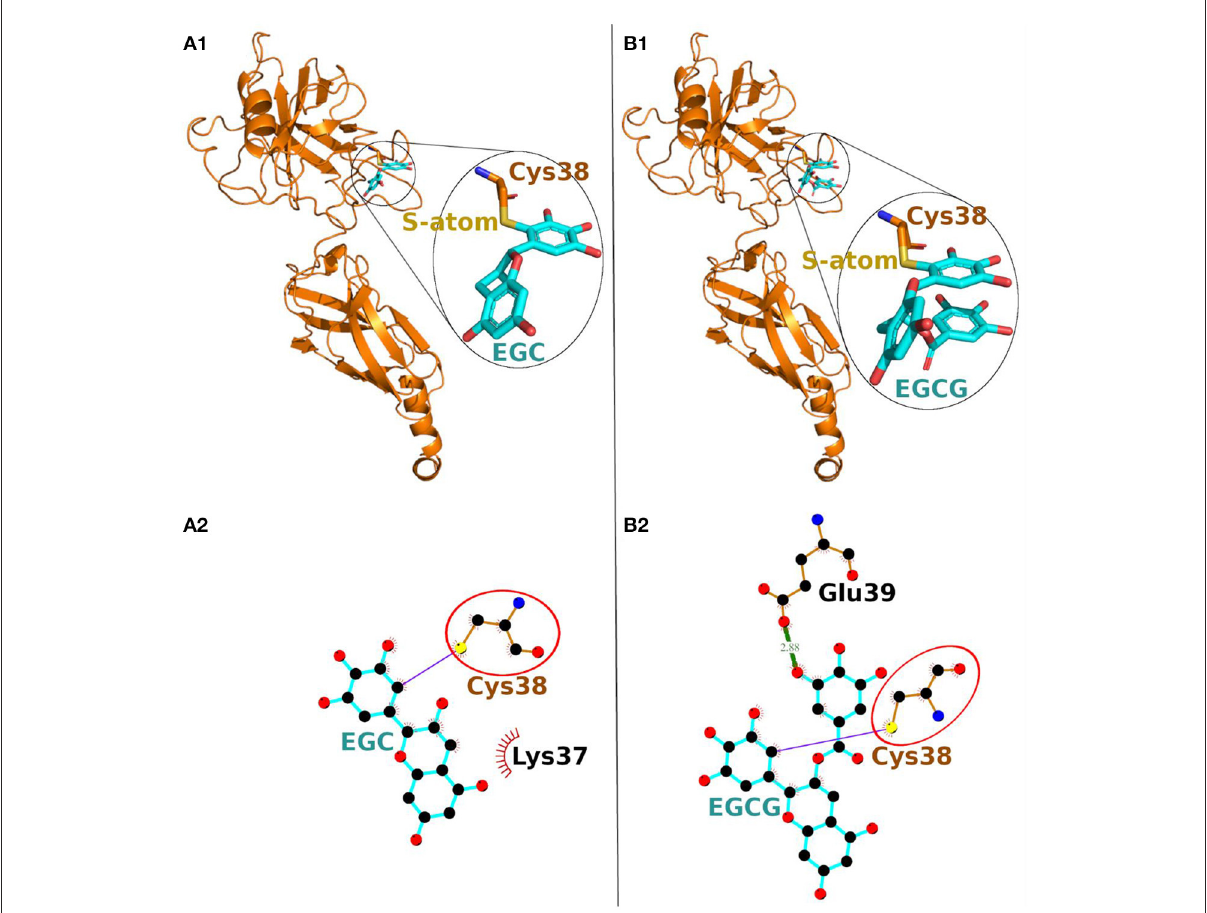
FIGURE3 Covalent docking of EGC (A) and EGCG (B) to NF- κ B p65. (A1, B1) The protein is shown in ribbon representation colored orange with Cys adducts. In inset, the Cys adduct is zoomed and shown in sticks representation with Cys-38 backbone colored orange, S-atom colored yellow and EGC and EGCG backbones in cyan. The O-atoms and N-atoms are colored in red and blue, respectively. (A2, B2) Ligand-protein interaction plots. The EGC and EGCG with Cys-38 are shown with backbone color cyan and orange, respectively with balls as atoms. The color of the balls decides atom types as the black color for C-atoms, the blue for N-atoms, red for O-atoms and yellow for S-atoms, respectively. The covalent bond with S-atom of Cys-38 is shown as purple line and the hydrogen bond as green line with bond length in Å. The residues forming non-bonded contacts are shown as red comb like structure. The common interacting residue, Cys-38 is encircled.